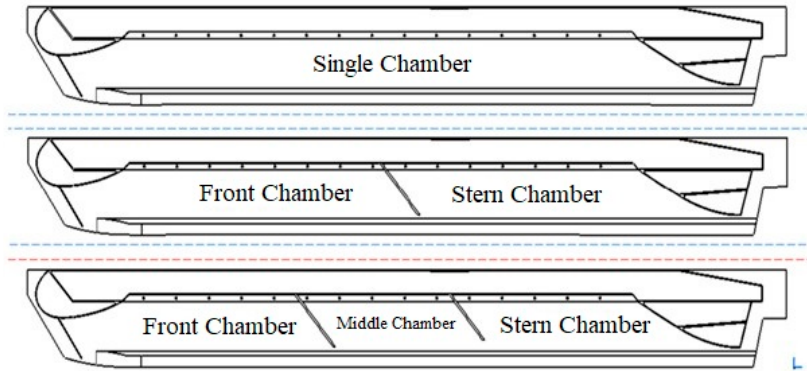
Figure 19. Models of air cushion compartment model-1 (single chamber), model-2 (two chambers) and model-3 (three chambers).